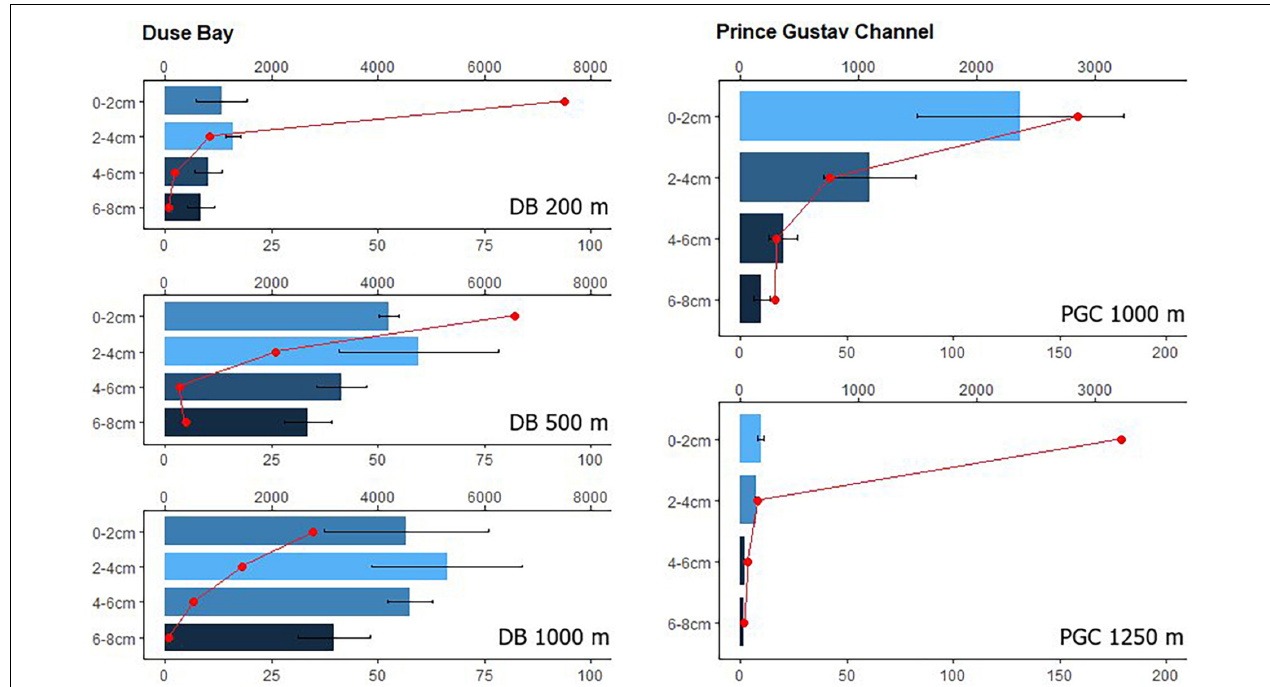
FIGURE 2 | Comparison between Duse Bay stations (from the top 200 m, 500 m and 1,000 m depth) and the Prince Gustav Channel (from the top 1,000 m and 1,250 m depth). The barplot shows Chl-a concentrations ( µ g/g, bottom axis, plus Sd) within the sediment layers (0–2, 2–4, 4–6, and 6–8 cm). Meiofauna distribution within the same layers expressed in ind 10 cm − 2 (upper axis) was plotted over the barplot. One replicate per layer was used to calculate meiofauna densities. Note the difference in scale between DB and PGC stations.